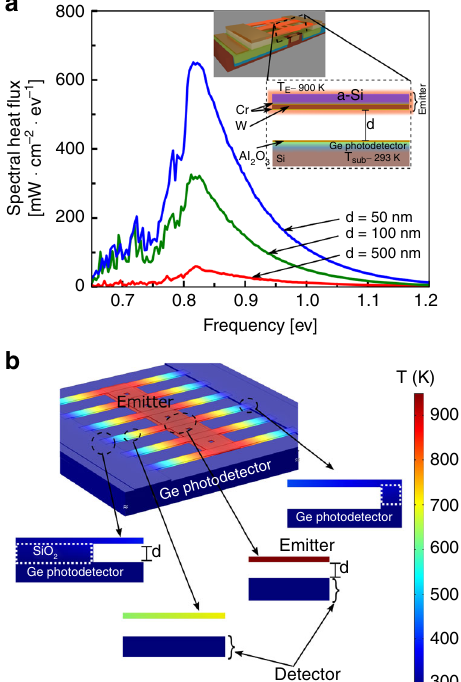
Fig. 2 Computational analysis of near- fi eld heat transfer in our thermo- photovoltaic cell. a Calculated spectral heat fl ux of thermal radiation absorbed by room-temperature germanium when the hot-emitter (aSi-Cr- W-Cr) is placed at near- fi eld distances (50 nm, blue-line, 100 nm, green line) and, far-away (500 nm, red-line). Inset shows: schematic of the material stack of emitter and photodetector of the thermo - photovoltaic cell. In the hot-stack, chromium (Cr) fi lm helps in adhesion and nucleation of tungsten thin- fi lm, while a-Si provides mechanical support when the bridge is suspended. The cold-stack is composed of Ge-on-silicon and covered with 10 nm alumina (Al 2 O 3 ) to protect the surface and avoid any unwanted current leakage from bridge to photodetector in case of shorting during measurement. The temperature of the emitter is assumed to be 900 K. b Simulated temperature distribution in the structure when the emitter is heated up to high temperatures. The insets show the cross-section of the structure at different positions. One can see that the when the emitter is hot (shown by red) the clamped edges at the pad and the substrate remain at room-temperature (shown in blue), due to high-thermal resistance of the thin- fi lm emitter.